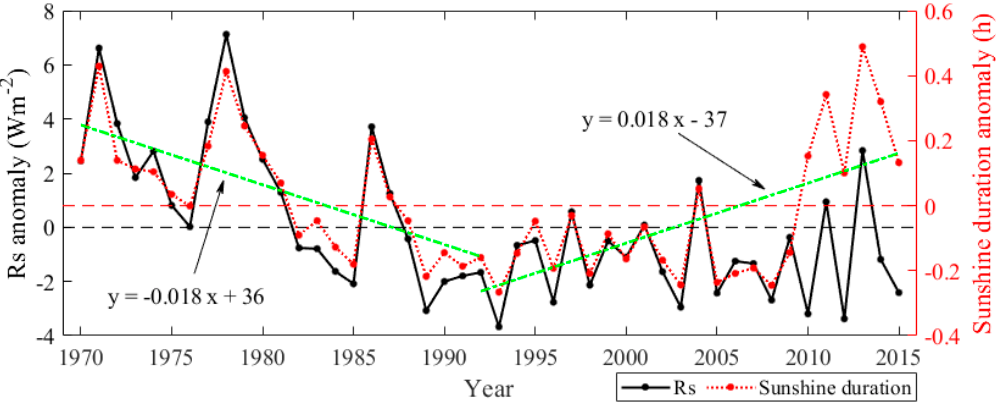
Figure 14. Comparison of the anomaly of the annual mean Rs and sunshine duration between 1970 and 2015. The green dashed lines are linear trends of 1970–1992 and 1992–2015.